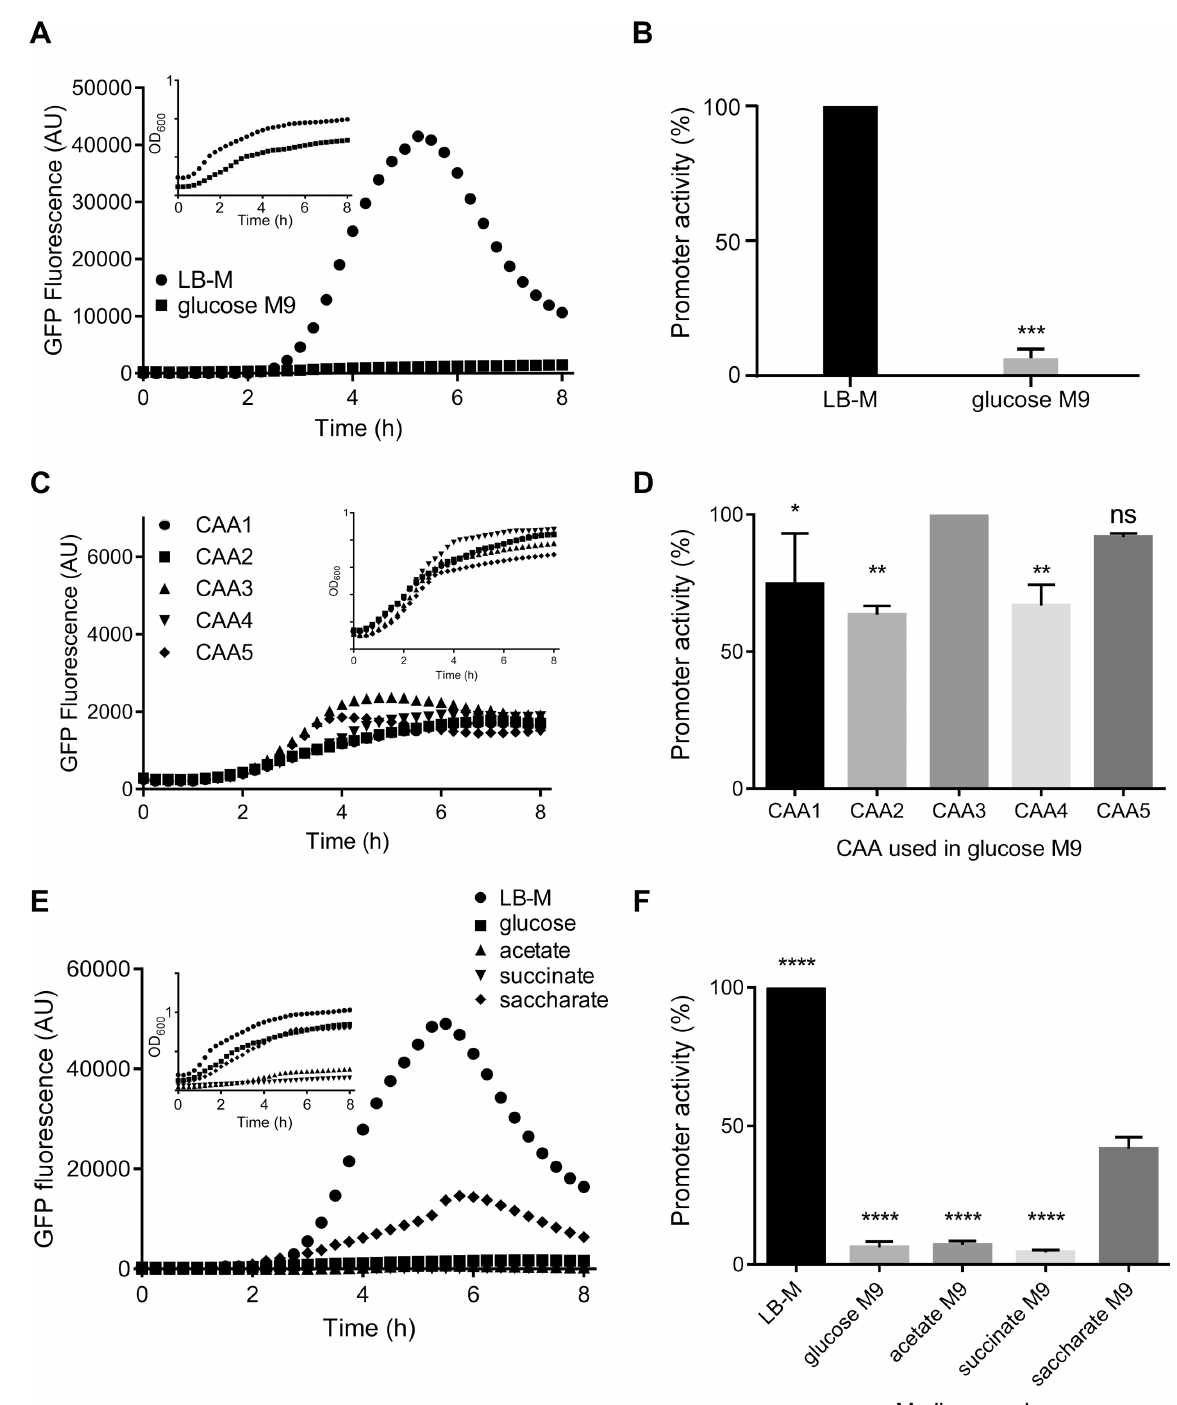
Fig 3. SPI-1 induction varies in M9 minimal medium. A, C, E. P prgH activity of the SPI-1 reporter strain (P prgH -gfp [LVA]) from one representative experiment. B, D, F. Comparing LB-M to glucose M9, glucose M9 containing different brands of Casamino acids, and 3 alternative carbon sources in M9, respectively. % promoter activity was calculated from n = 3 at maximum promoter activity of GFP/OD600; normalized to LB-Miller grown bacteria (B and F) or those grown with CAA3 (D). The Casamino acids used are ‘ existing ’ Bacto (CAA1), Bacto (CAA2), Bacto Technical (CAA3), Sigma (CAA4), Remel (CAA5). Statistical analyses were unpaired t-test with Welch ’ s correction (B) or a one-way ANOVA with Dunnett ’ s multiple comparisons test (D, F). Data shown are mean ± SD ( * p <